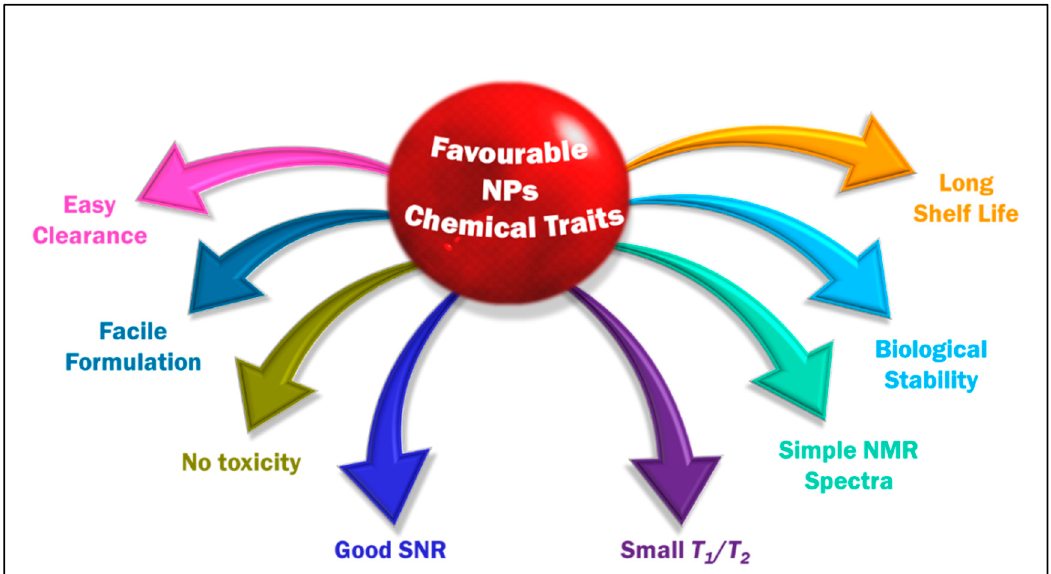
Figure 2. The favorable characteristics of a CA for 19 F MRI.